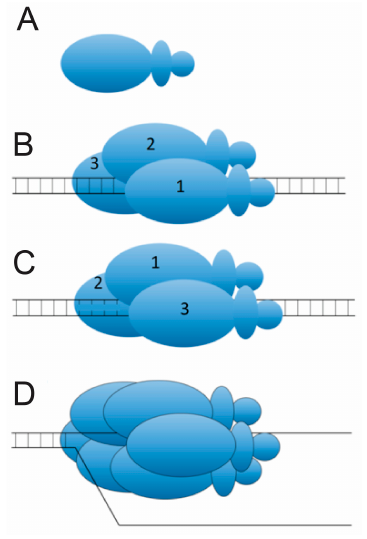
Figure 7. The E1 “Unwinding” Mechanism of Origin Melting. ( A ) An illustration of an E1 monomer. Twelve of these constitute an E1 double hexameric complex shown to unwind DNA after initial melting; ( B ) Pre-twist: Assembly of a single trimer of E1 monomers around dsDNA, and the insertion of histidine residues into the dsDNA; The numbers 1, 2, and 3 demark the three subunits of the trimer. ( C ) Post-twist: The slight rotation, or “twist”, has resulted in a melted origin and reorientation of the three subunits as a result; ( D ) Assembly of a single hexamer of E1 onto ssDNA post